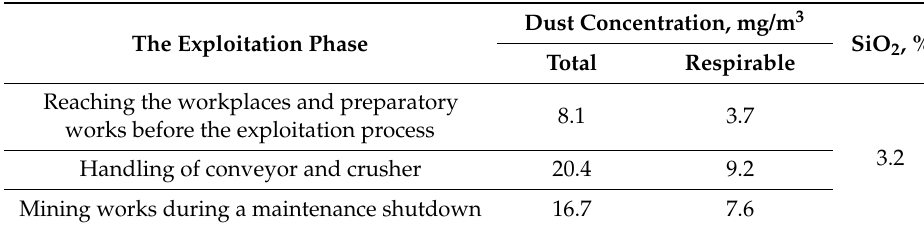
Table 11. The measurement results for the dust levels for selected activities, in the working position a miner operating the belt